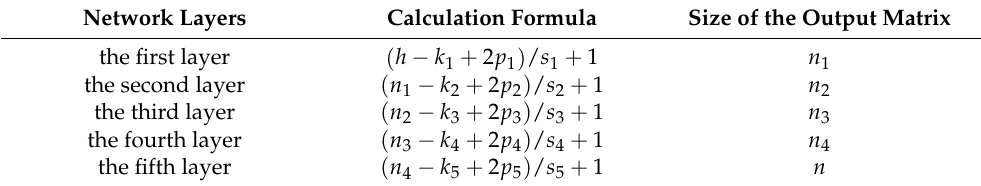
Table 1. The size of the output matrix of each layer of the network, where h represents the size of the input image, k 1 − k 5 represent the sizes of each convolution kernel from the first layer to the fifth layer, p 1 − p 5 represent the amounts of padding from the first layer to the fifth layer, s 1 − s 5 represent the sizes of each convolutional step from the first layer to the fifth layer, n 1 − n 4 represent the sizes of the output matrix from the first layer to the fourth layer and n represents the size of the final output matrix from the discriminator. Network Layers Calculation